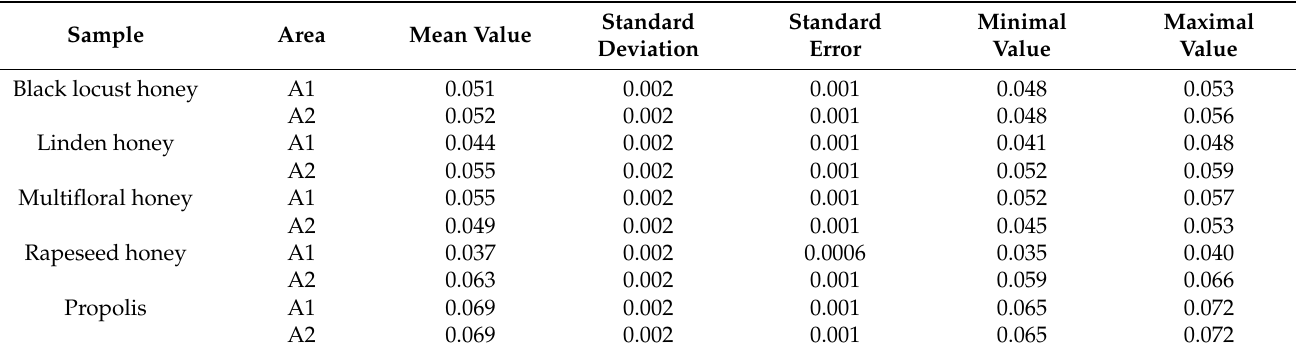
Table 9. Bioconcentration factor for Cr.